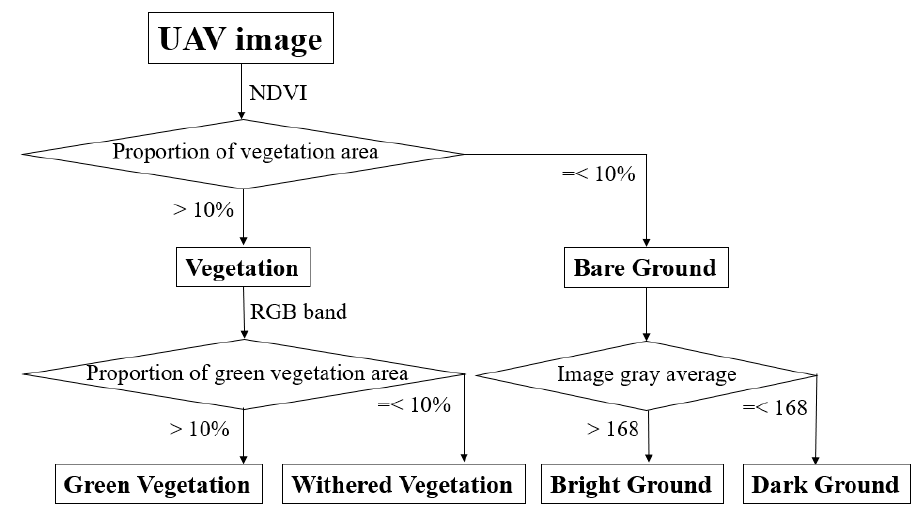
Figure 3. Flowchart of dataset construction.